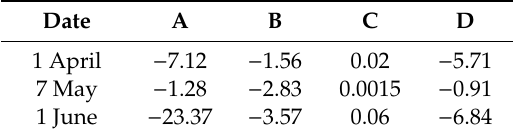
Table 1. Parameter values used in the water cloud model for the study area.